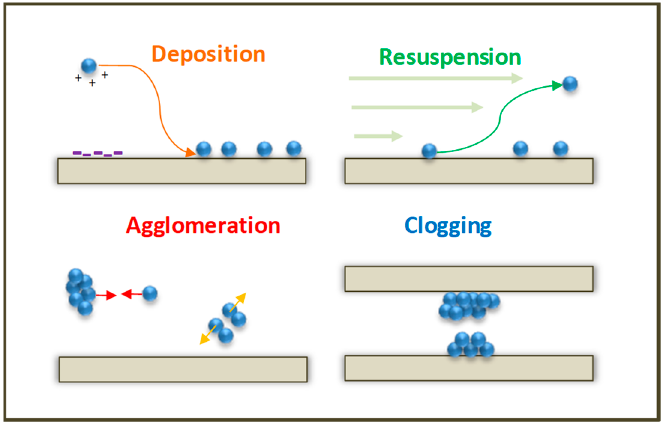
Figure 1. The four elementary phenomena of fouling.